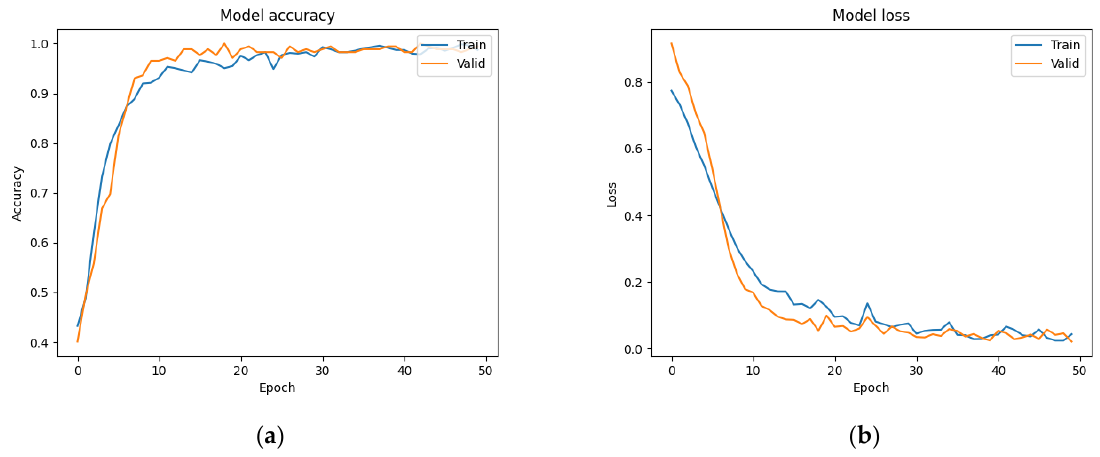
Figure 9. ( a ) Training accuracy and ( b ) training loss of ResNet model on our dataset. Table 1. Confusion matrix of the model.